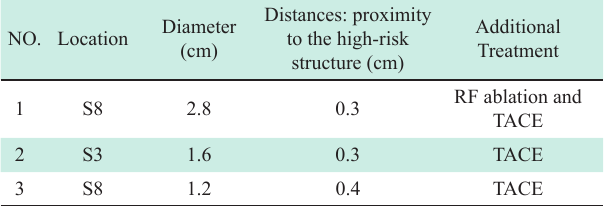
Table 3 Characteristics of local tumor progression Distances: proximity Diameter NO. Location to the (cm)